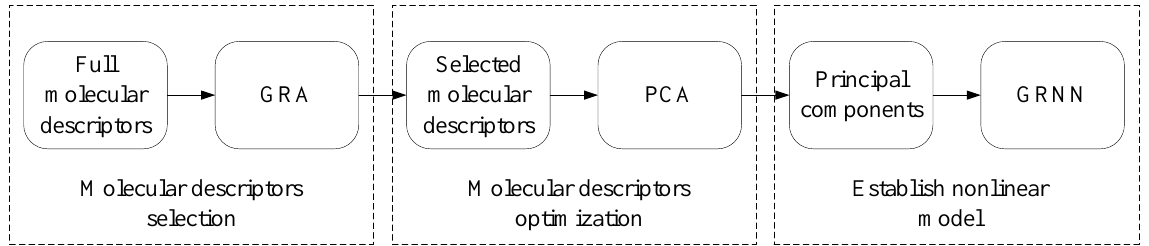
Figure 2. Flow chart of GP-GRNN model calculation (GRA, grey relational analysis; PCA, principal component analysis).